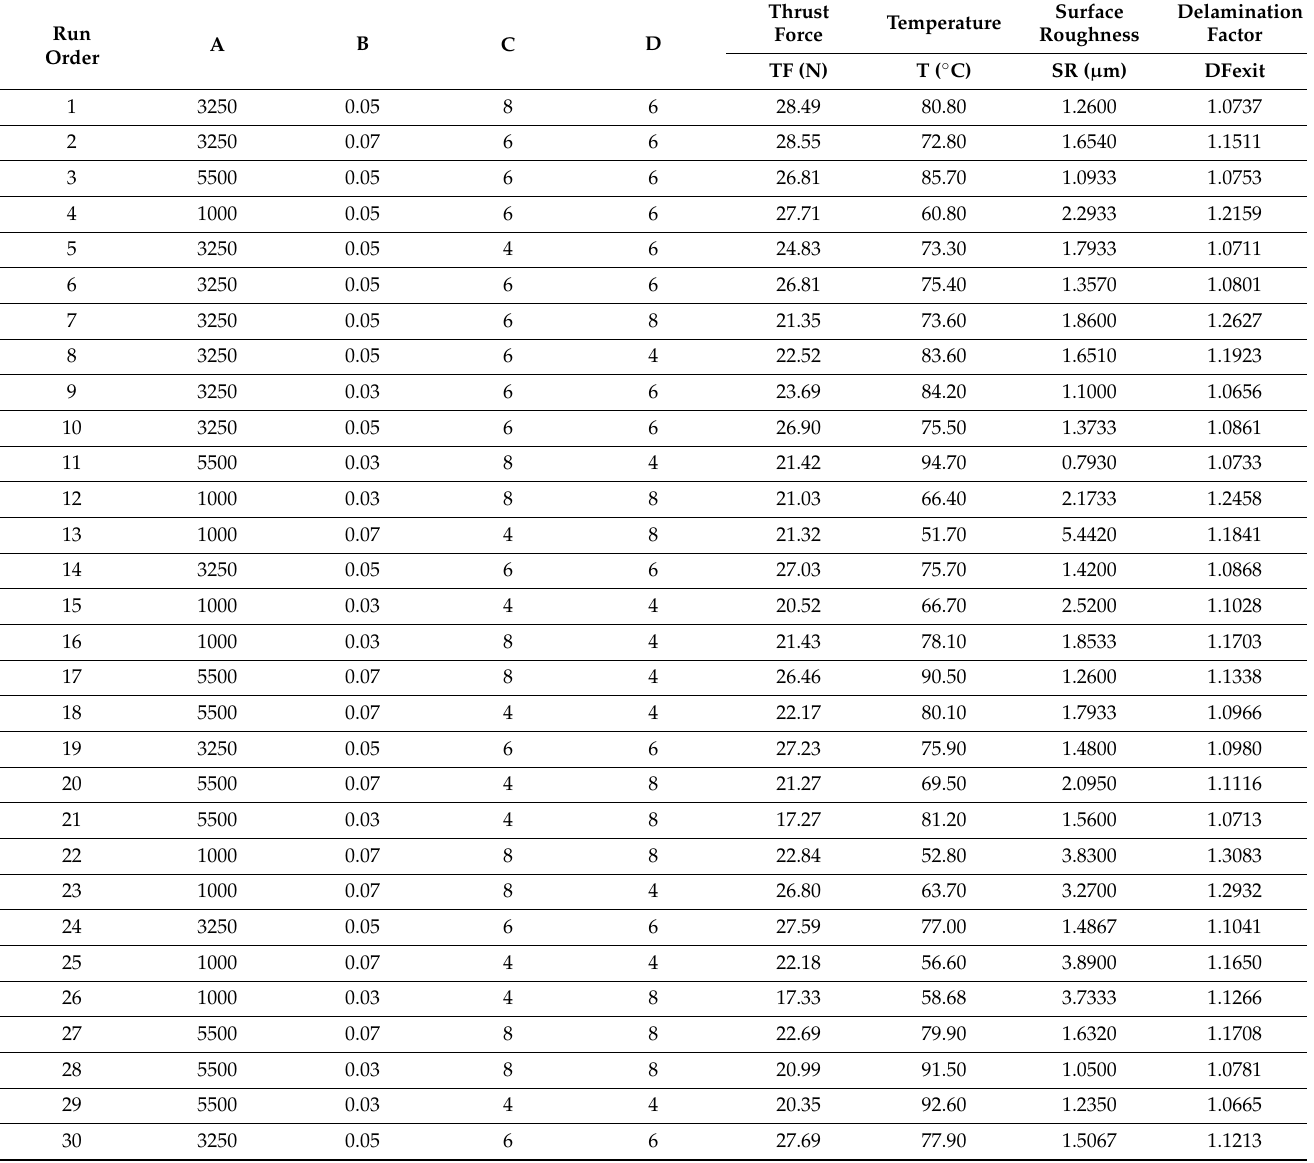
Table 5. Drilling experiment design matrix and responses of h-BN-reinforced